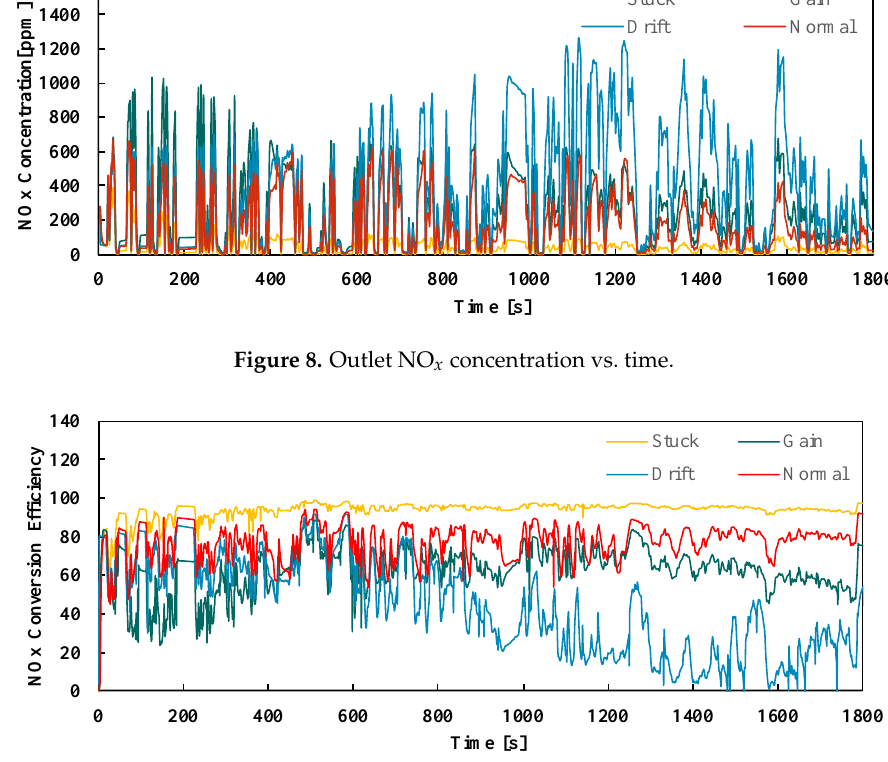
Figure 9. NO x conversion efficiency vs. time.